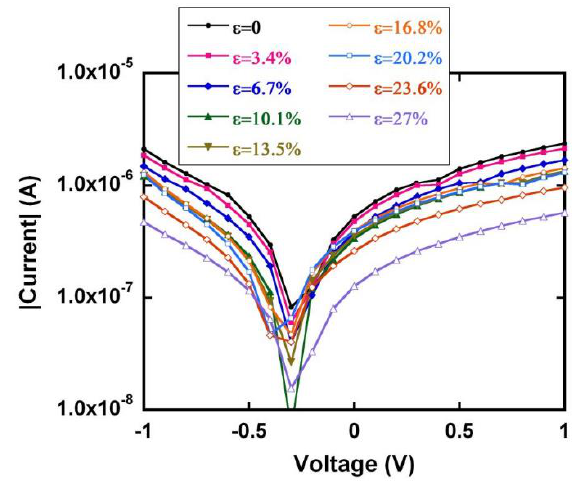
Figure 5. LRS current characteristics for the NT resistive memory under applied different ε values.